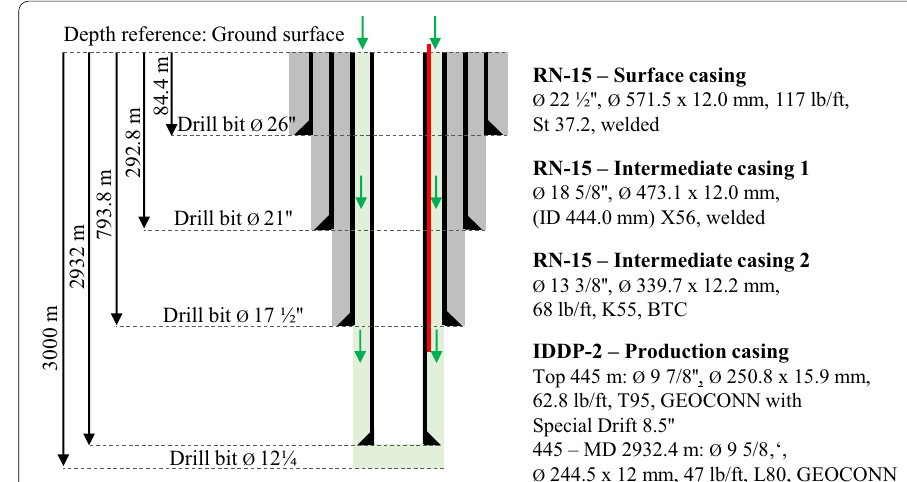
Fig. 1 Design of the well and landing depth of fiber optic cable (red line). The cementing section is displayed in green color